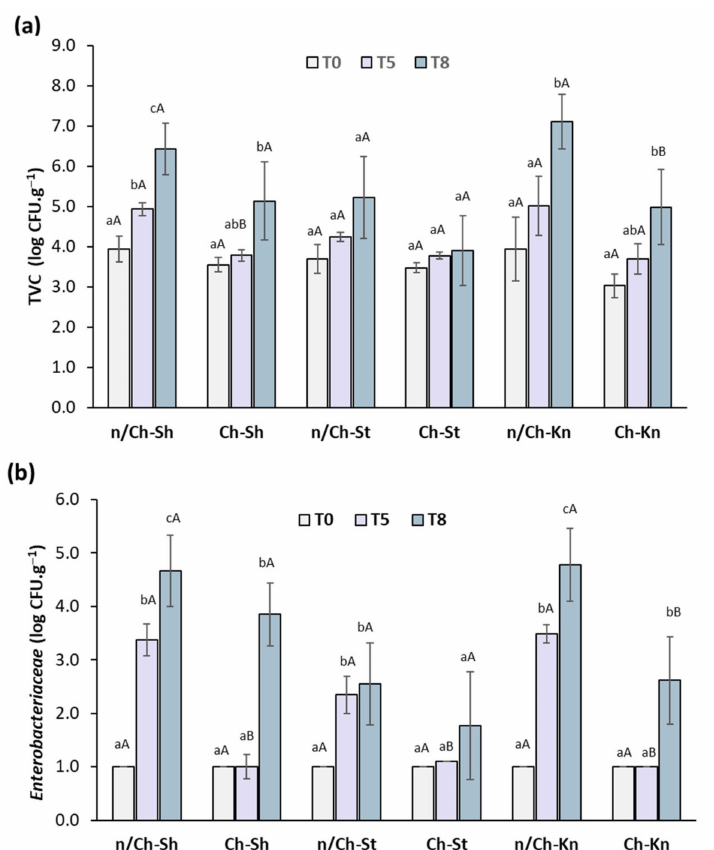
Figure 3. TVC ( a ) and Enterobacteriaceae count ( b ) of vacuum-packed beef cut samples over the storage period of 0 (T0), 5 (T5) and 8 (T8) days at 4 ◦ C. n/Ch–Sh = non-coated shoulder; Ch–Sh = coated shoulder; n/Ch–St = non-coated striploin; Ch–St = coated striploin; n/Ch–Kn = non-coated knuckle; Ch–Kn = coated knuckle. Columns represent the mean ( n = 3) and the bars represent the standard deviation. a–c Different letters indicate significant differences ( p < 0.05) for the same beef cut sample over the storage period (T0, T5 and T8). A,B Significant differences ( p < 0.05) between the different beef cuts on the same storage